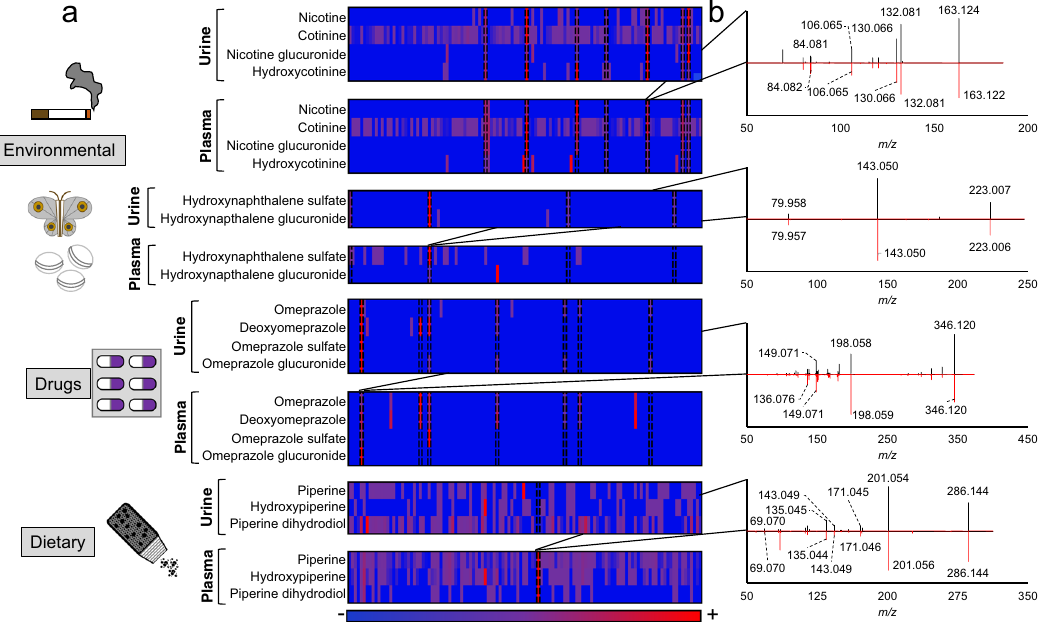
Fig. 6 Identi fi cation of undocumented xenobiotic exposures. a Heatmap of relative peak intensities of related xenobiotics in 120 humans (each column from left to right represents an individual sample) with paired urine and plasma samples. Metabolites were detected at the same accurate mass m / z and retention time as S9-enzyme generated metabolites. Relative abundance values were colored across each row using the maximum observed peak intensities (red) and minimum observed peak intensities (blue) for a particular metabolite. b MS 2 spectra of selected metabolites (nicotine, hydroxynapthalene sulfate, omeprazole, piperine) in experimental sample (black) compared with S9-reactions